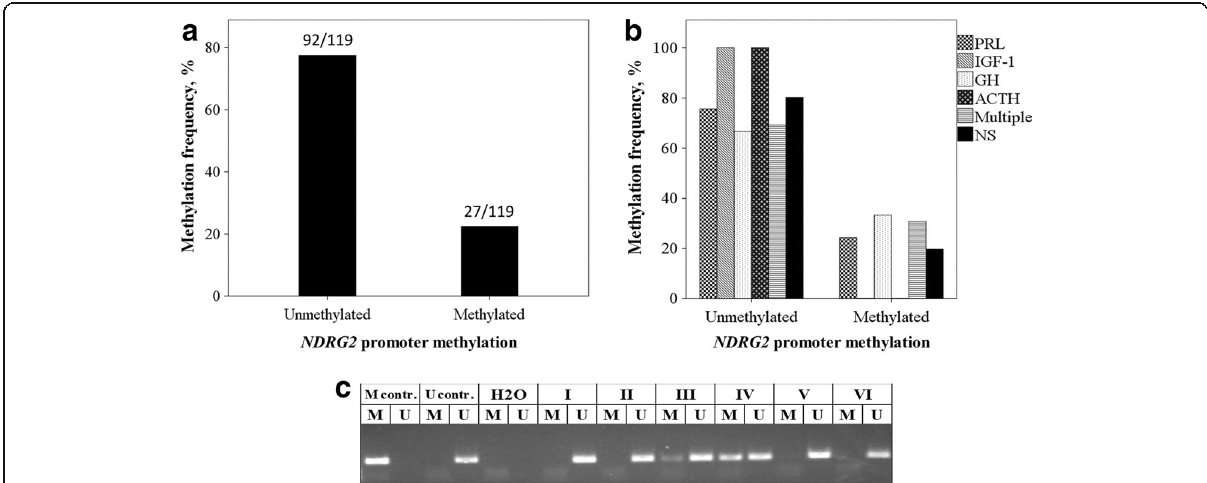
Fig. 1 Analysis of NDRG2 gene promoter methylation in PA samples. a Methylation frequency (%). b Hormone distribution of PAs in methylated and unmethylated NDRG2 promoter groups. PRL – prolactin, IGF-1 – insulin-like grow factor 1, GH – growth hormone, ACTH – adrenocorticotropic hormone, multiple – PAs secreting more than one hormone, NS – non-secreting PAs. c Representative MS-PCR for NDRG2 in PA samples. M indicates amplification of methylated alleles, U unmethylated alleles. M cont. – positive methylation control (Standard Bisulfite Converted Universal Methylated Human DNA), U cont. – negative methylation control (normal human peripheral lymphocytes), H2O – water control, I-VI designate PA